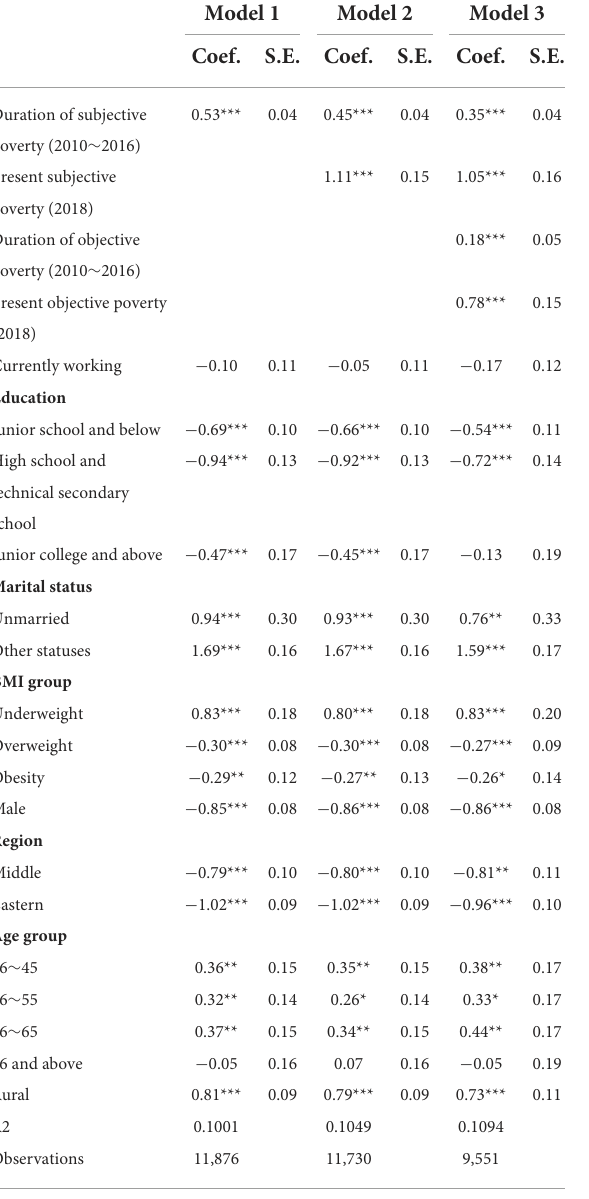
TABLE 7 Duration of subjective poverty and depressive symptoms in the urban sample.